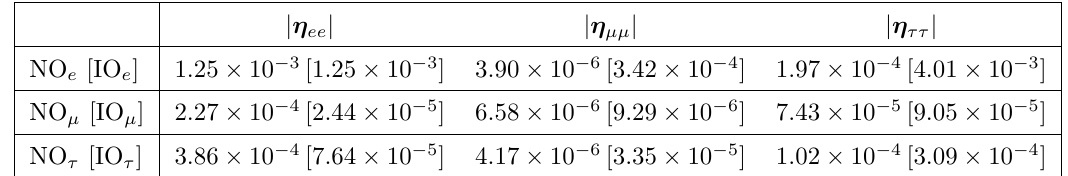
imposed by EWPD (see text for details) for NO eN